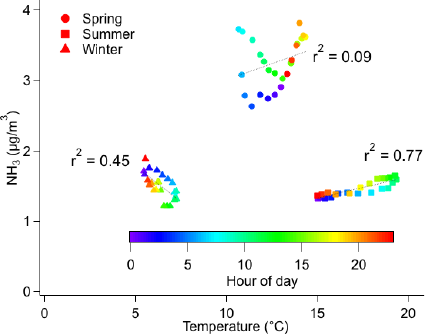
Figure 11. Correlation between ammonia and temperature in spring (circles), summer (squares) and winter (triangles) colored as a func- tion of the hour of the